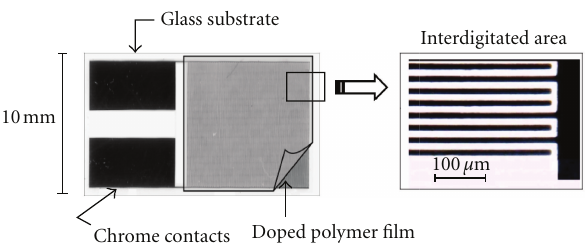
Figure 2: Structure of the interdigitated polymeric